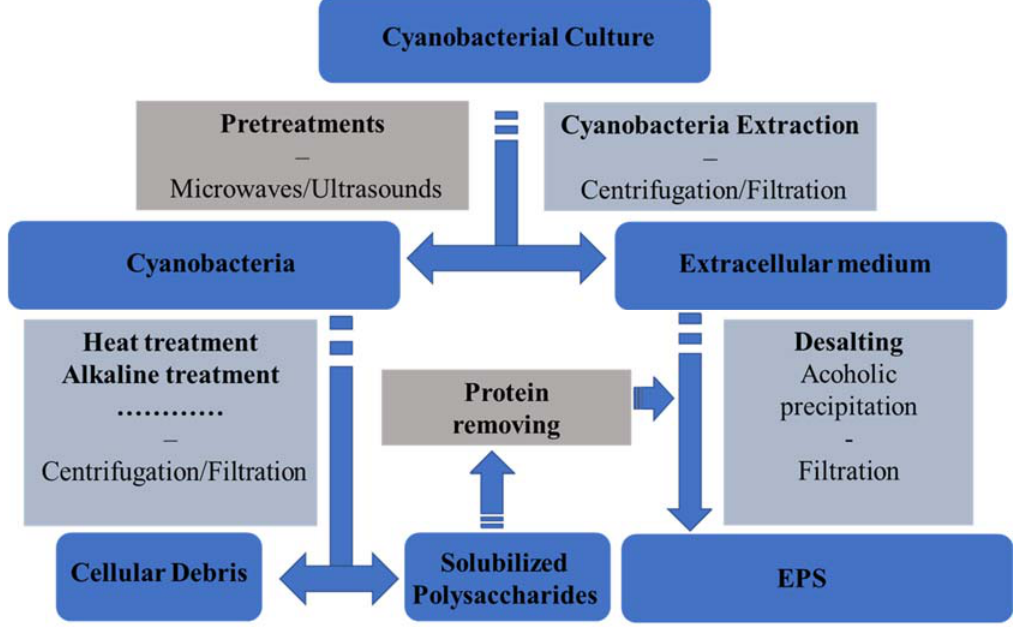
Figure 1. Process flow chart for the extraction of EPS from cyanobacteria.